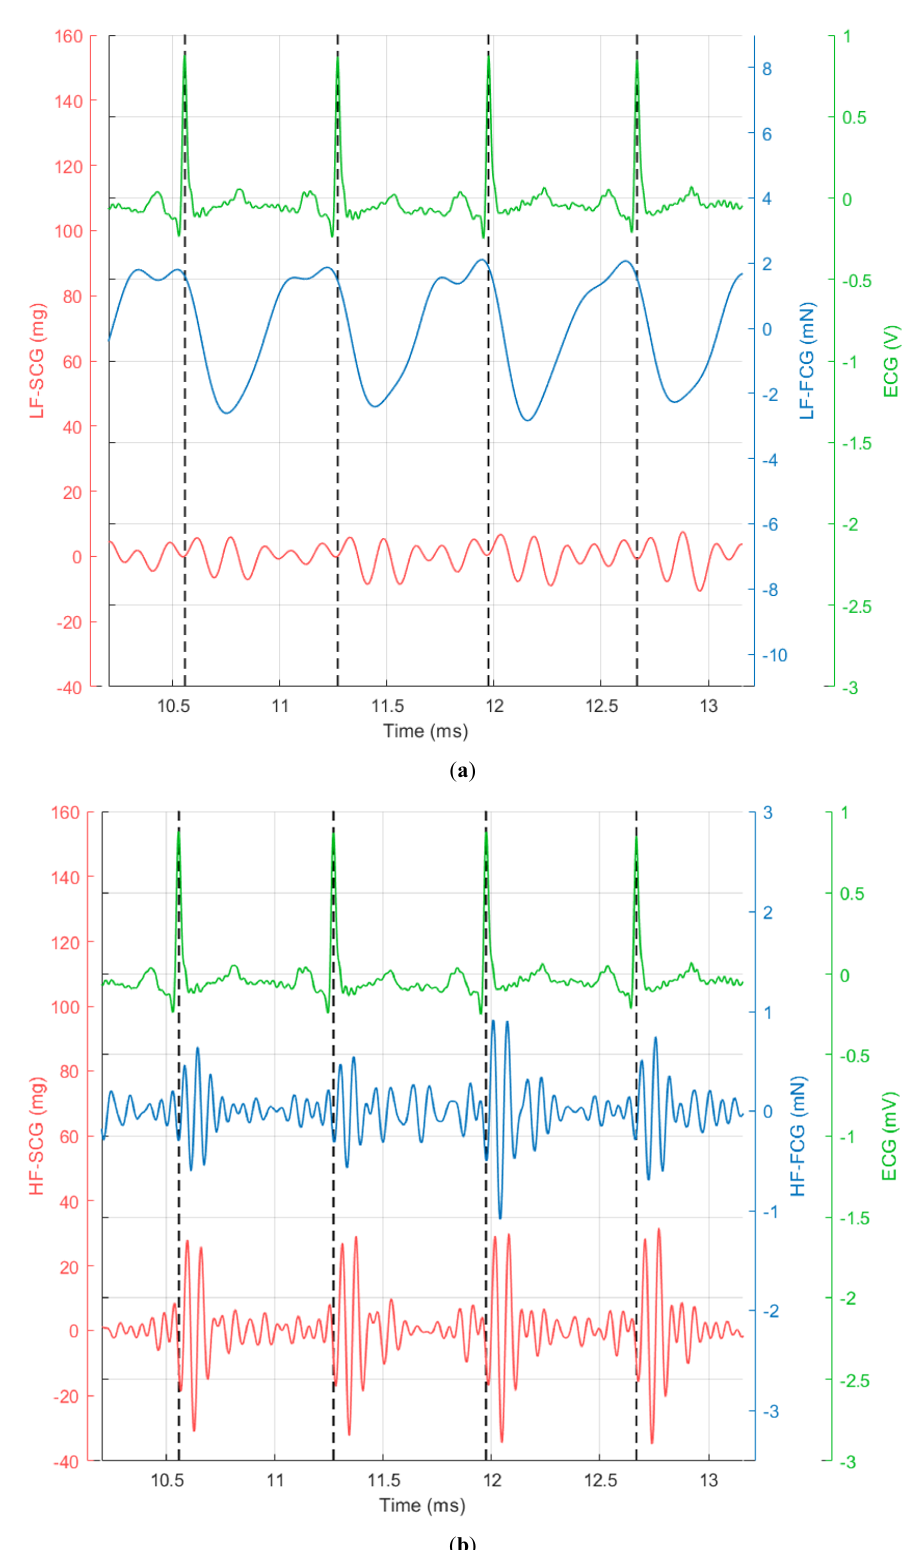
Figure 5. Subject #2 dataset: ( a ) ECG with low-frequency components of FCG and SCG; ( b ) ECG with high-frequency components of FCG and SCG. ECG is shown in green and scaled in mV, FCG is shown in blue and scaled in mN, SCG (dorso-ventral acceleration) is shown in red and scaled in mg. The R-peaks time references correspond to the black dashed